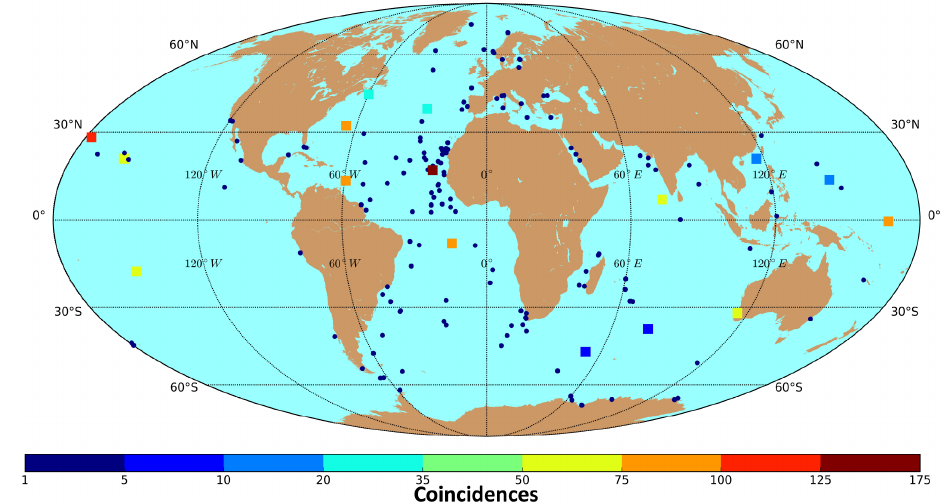
Figure 2. Map showing the geographical distribution of 951 MISR-AERONET and 178 MISR-MAN validation cases. Squares are used for AERONET sites and circles for MAN. Symbol color indicates the number of coincidences for each MAN/AERONET